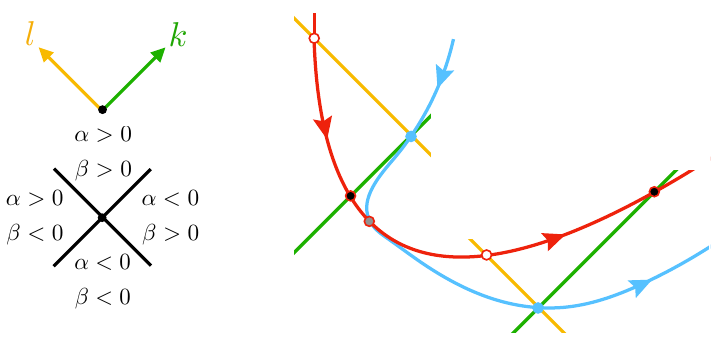
Figure 4 . Illustration of the intersection construction of generalized holographic screens. Arrows indicate the direction of increasing (cid:28) . Examples of leaves (cid:27) ( (cid:28) ) in the holographic screen H (red curve) are given by the white dots and the corresponding (cid:27) ( f ( (cid:28) )) is given by the immediately succeeding black dot. A leaf (cid:27) 0 (blue dot) of the generalized holographic screen H 0 (blue curve) is given by the intersection of N l ( (cid:27) ( (cid:28) )) (yellow line) and N k ( (cid:27) ( f ( (cid:28) ))) (green line) as shown in eq. (2.15). The function f ( (cid:28) ) (cid:28) equals (cid:28) precisely when H has null tangent (gray (cid:21)